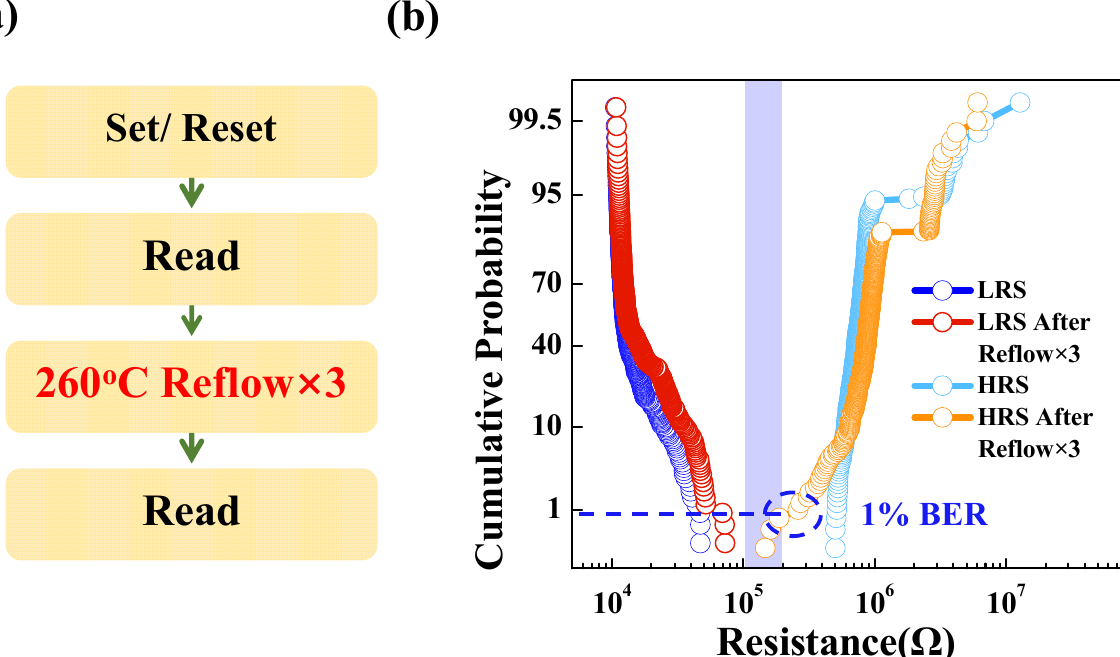
Figure 2. ( a ) The test flow chart of reflow. ( b ) The HRS and LRS distributions before and after the reflow process 3 times at 260 °C for Ta IL devices.